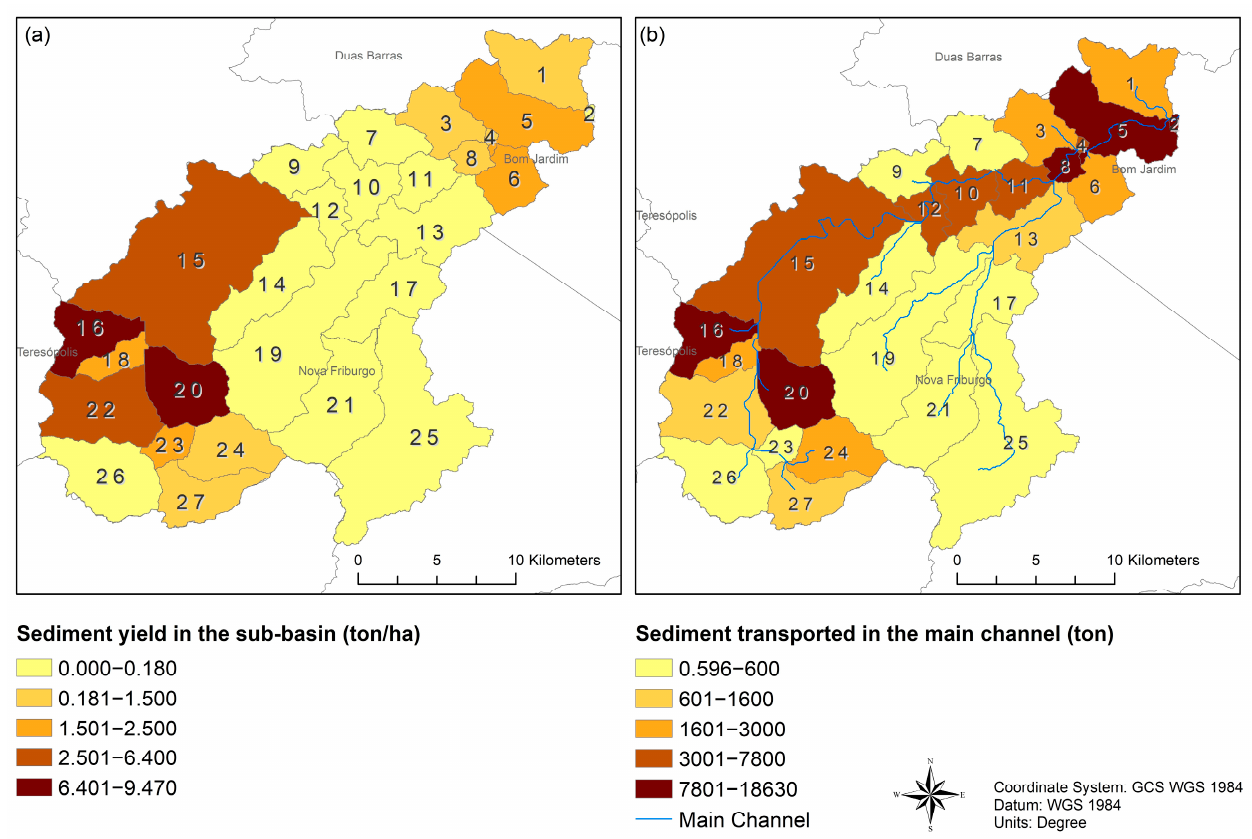
Figure 10. ( a ) Map of sediments produced in the sub-basins. ( b ) Map of sediments transported in the main channel. The limit of each sub-basin is referenced by the numbers indicated in the figure and can be associated with Tables 5 and